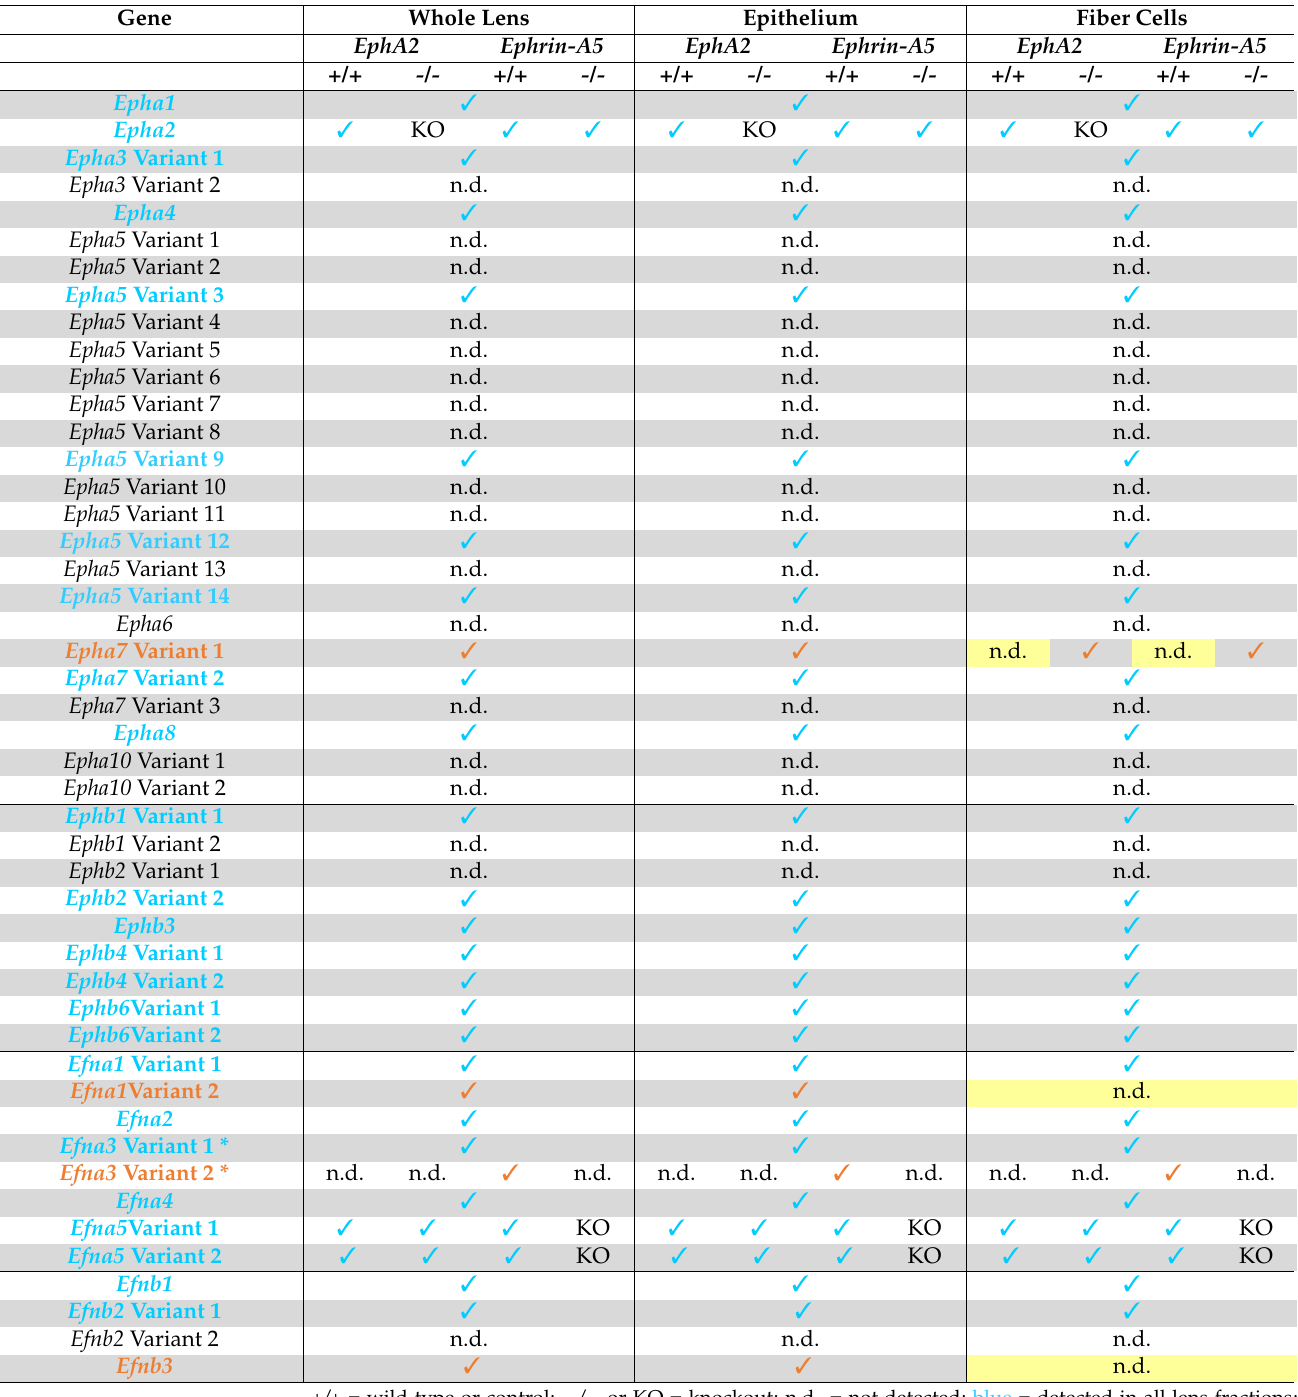
Table 1. Eph and Efn transcripts in the lens. Gene Whole Lens Epithelium Fiber